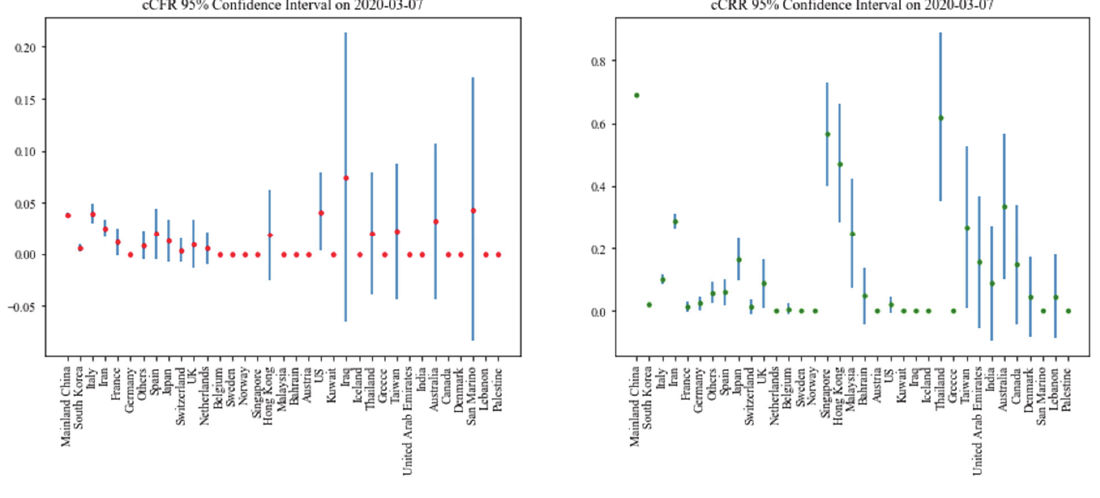
Fig. 1. The CIs plot of cCFR and cCRR for the 35 most affected countries on 7 Mar. 2020